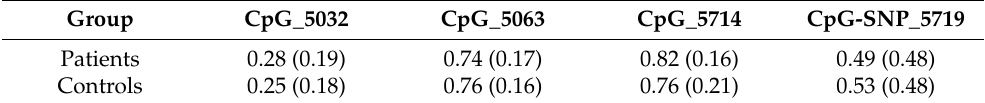
Figure 1. The interrogated fragment within the CYP17A1 gene and variably methylated CpG sites (VMS) within it. The fragment view in the UCSC genomic browser ([13], http://genome.ucsc.edu, accessed on 5 September 2022) is presented. Exons 2 and 3 (striped rectangles), intron 2, and parts of introns 1 and 3 (the line with arrows indicating the direction of transcription) of the CYP17A1 gene are given; the white arrow indicates where the transcription start site (TSS, chr10:104,597,290) is located. VMS positions are shown with red arrows. TFBS are shown as grey and black rectangles. The CTCF binding site is highlighted (blue). Table 2. DNAm (mean, SD) at variably methylated sites in patients and controls.